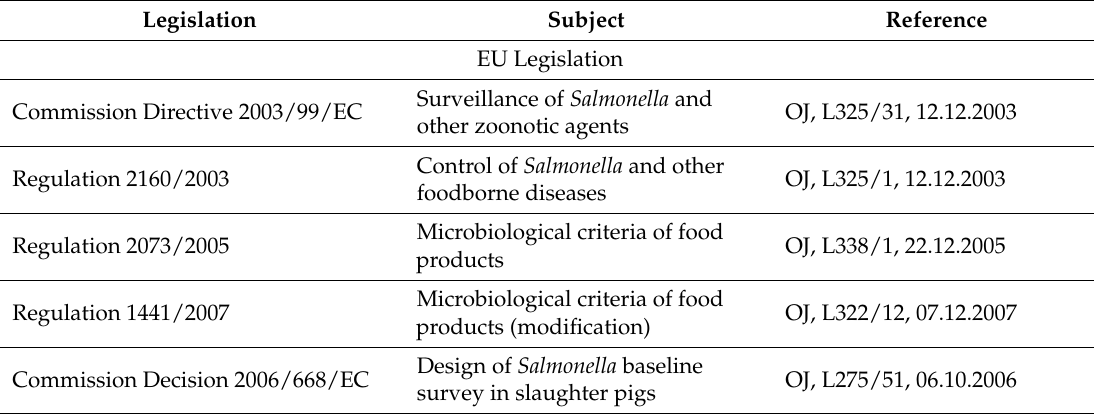
Table 3. Relevant legislation for swine-related Salmonella